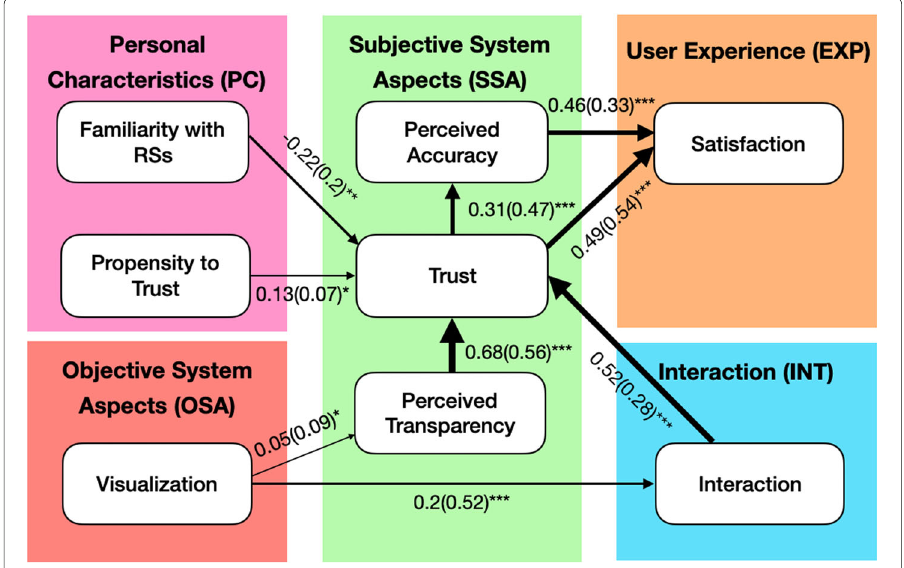
Fig. 10 The structural equation model of the experiment. Pathways represent significant relationships, with numbers and thickness indicating regression coefficients (with robust SE). All factors in the model have been scaled to have a standard deviation of 1. Significance levels are *** p<0.01, ** p<0.05, *